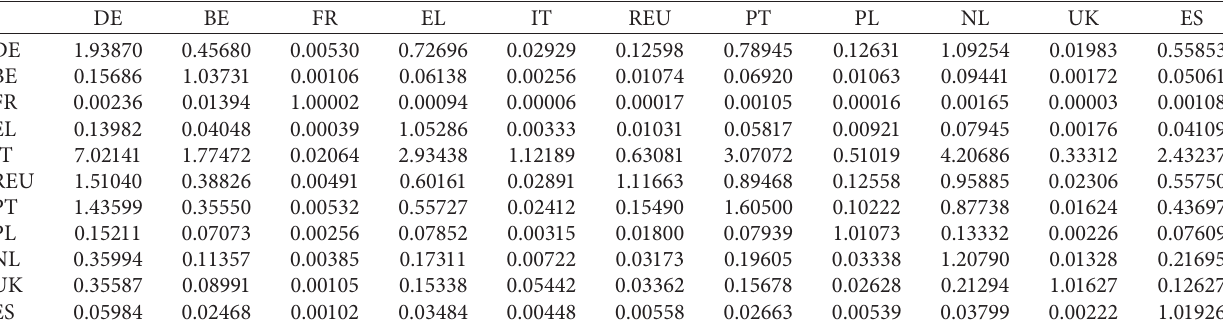
Table 12: Triangulated matrix 2017.